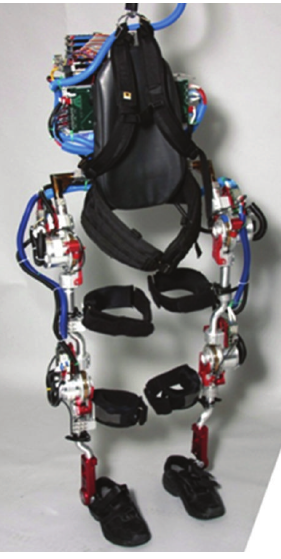
Figure 1: The IHMC Mina sensorimotor robotic orthosis for mobility assistance prototype. Mina adjusts to fit users ranging from ∼ 1.6 m to 1.9m